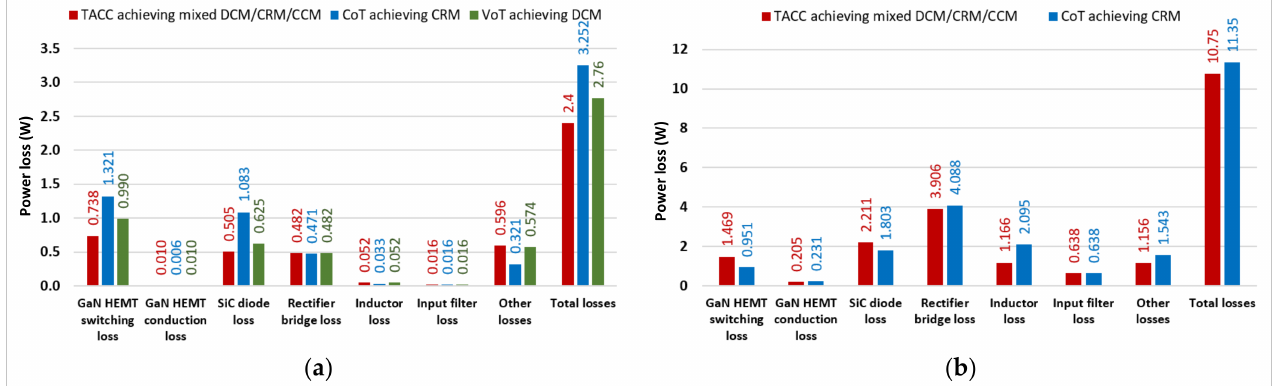
Figure 21. Loss breakdown with 220 VAC input ( a ) under 80 W; ( b ) under 500